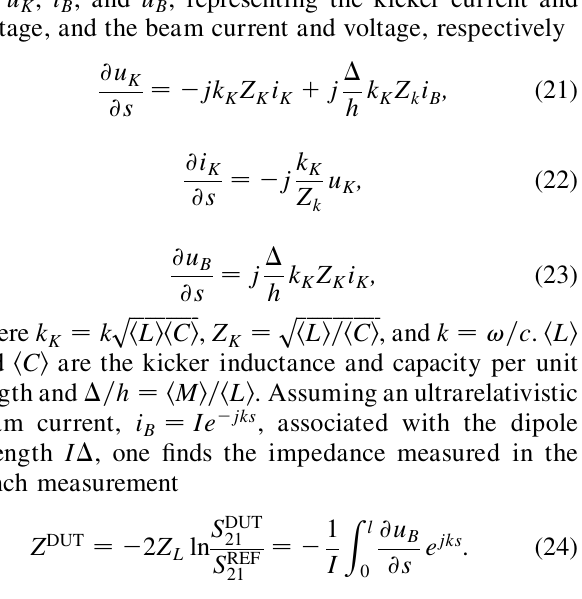
FIG. 12. Comparison of measured value of M=L mate for (cid:15) =h (cid:2) 0 : 366 for the half-size